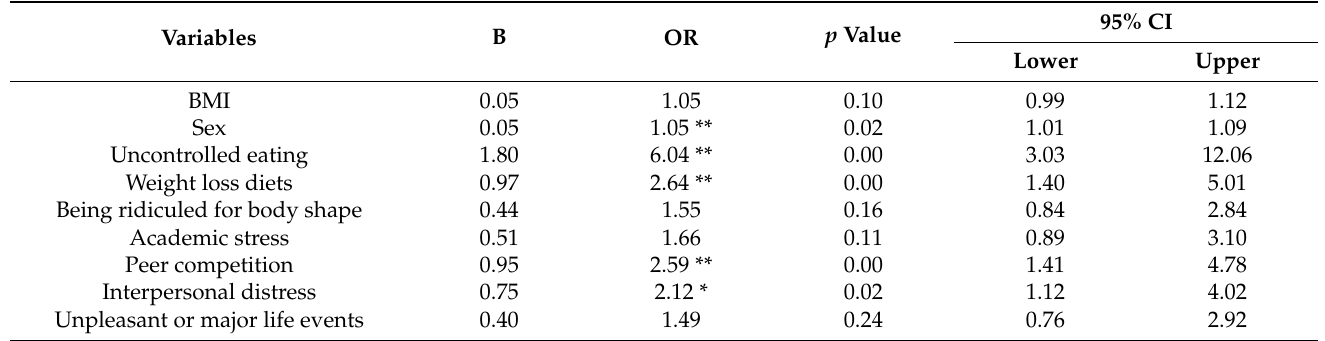
Table 3. OR of logistic regression analysis predicting risk of BE